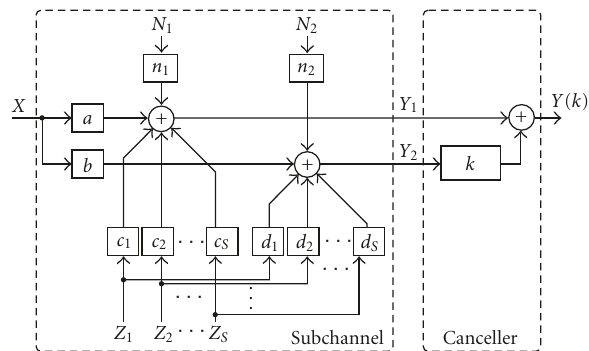
Figure 1: Model of the subchannel (1) and the corresponding scalar linear interference canceller